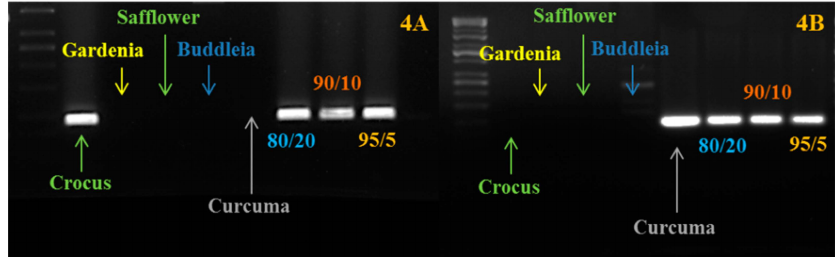
Figure 4. PCR amplification carried out using saffron and curcuma markers on saffron-curcuma artificial mixtures. ( A ) We show the amplification carried out using the crocus-specific marker; ( B ) We show the amplification carried out using the curcuma-specific marker. As expected, the amplification is present just in crocus, curcuma and in the mixtures. The ratio (such an 80/20) refers to the different percentages of saffron and curcuma powders mixed before the DNA